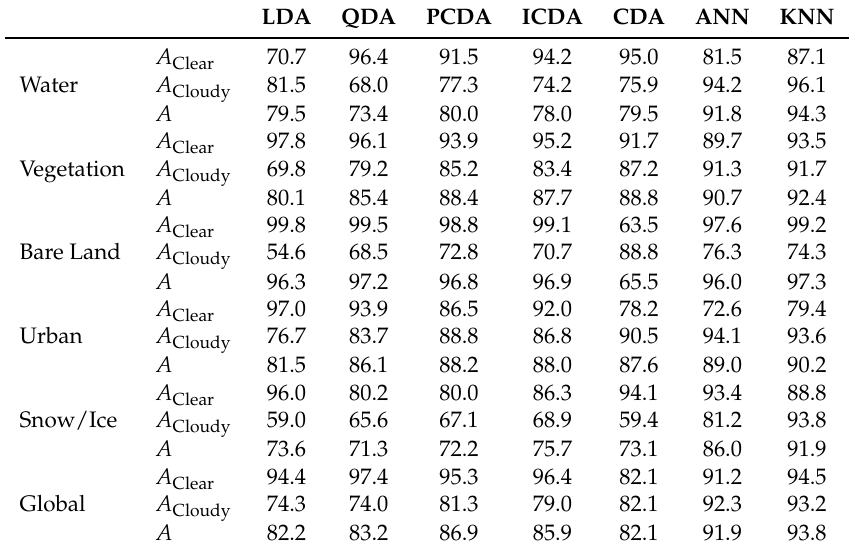
Table 5. Accuracy indicators A , A Clear and A Cloudy of classification methods of Section 3 when validation is made on the full dataset and no ancillary information on surface or climate is used. Percentage values are reported for the entire dataset (row Global) and sorted for different surface